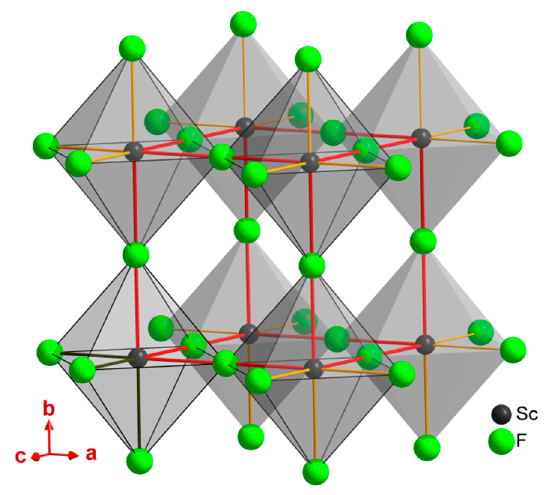
Figure 1. Crystal structure of cubic ScF 3 (space group Pm 3 m ) consisting of corner-shared regular ScF 6 octahedra.